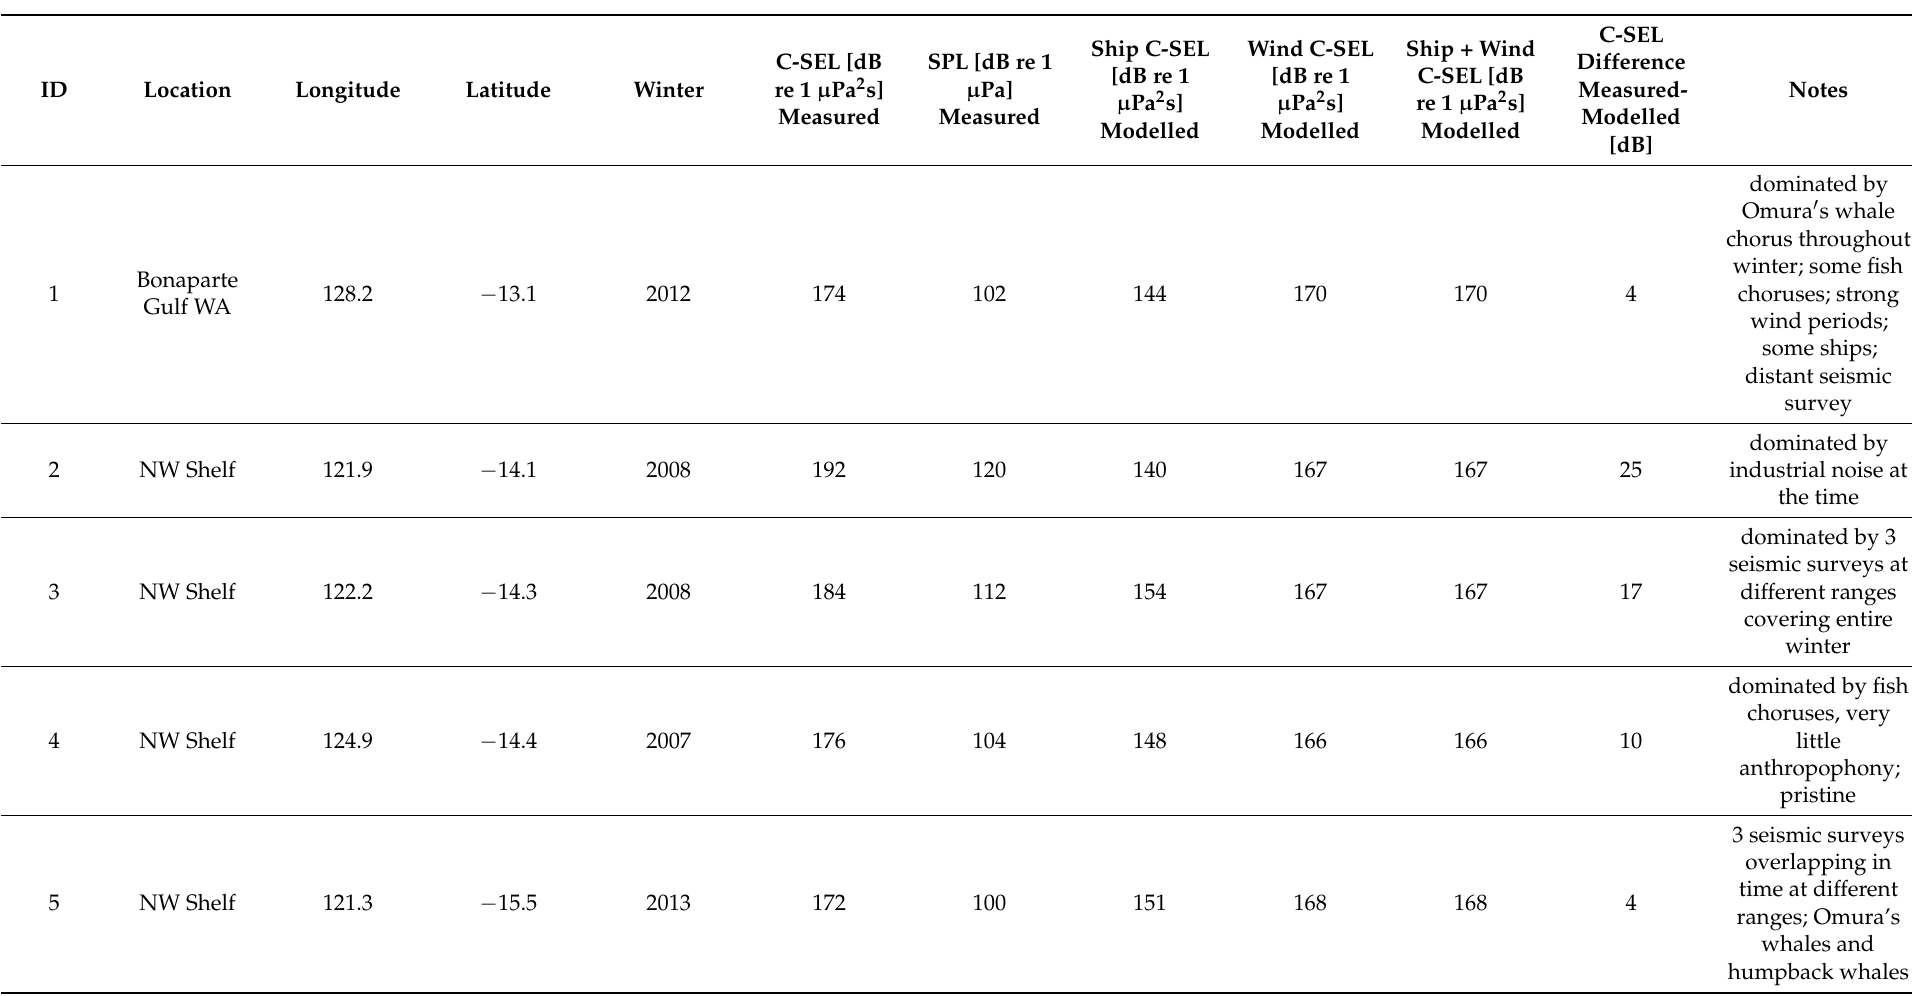
Table 1. Site ID, location, year, measured C-SEL and SPL, modelled C-SEL from ships, wind, and combined, C-SEL difference between model and measurement, and rough description of the